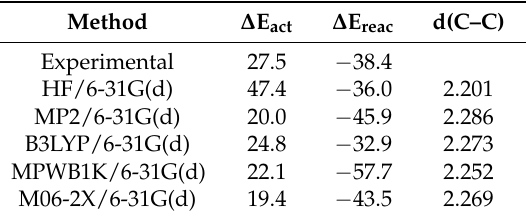
Figure 1. B3LYP/6-31G(d) map of the total electron density of the transition state structure TS1 associated with the DA reaction between butadiene 1 and ethylene 2 . Isovalues of the map of the electron density are 0.08.